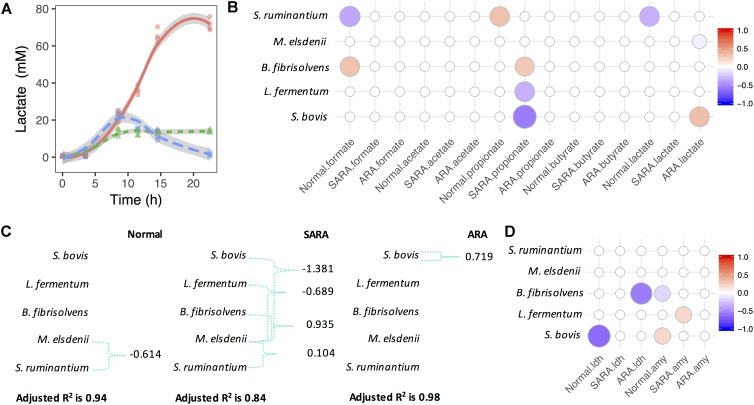
Megasphaera elsdenii combats lactate producers to maintain lactate balance in RAMs. (A) Lactate accumulation in RAMs. (B) Associations between bacteria relative abundance and OA accumulation in RAMs. Only significant associations were presented (P < 0.05). (C) The variation of lactate concentration explained by bacteria abundance and interactions. Green connections are statistical significant interactions (P < 0.05) and the model used here is: lactate ∼ sb + me + bf + lf + sr + me:(sb + bf + lf + sr). (D) Associations between bacteria relative abundance and enzymes’ activity in RAMs. Only significant associations were presented (P < 0.05).